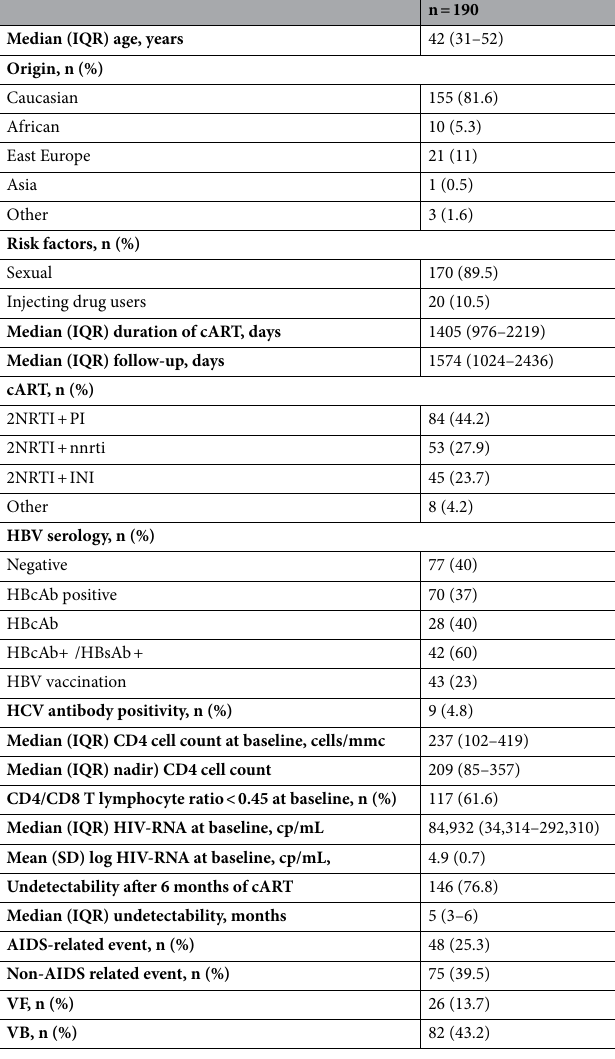
CD4+ and CD8+ T lymphocyte numbers and CD4/CD8 ratio in the 24 months after cART initia‑ tion in the two subgroups of HIV‑positive/HBcAb‑negative and HIV‑positive/HBcAb‑positive patients. Differences between HBcAb-positive and HBcAb-negative HIV patients are shown in Fig. 2A-C and in Table S1. Reduced CD4+ T lymphocyte absolute counts were found in the HBcAb-positive group before starting cART (baseline: 185 cells/mmc [88–373] vs. 271 cells/mmc [118.5–445.5], p = 0.02; in the HBcAb-posi- tive group vs. HBcAb-negative group, respectively) (Fig. 2A). With respect to CD4/CD8 ratio values (Fig. 2C), no difference was noted between the two patient groups up to 3 months after cART initiation. From 4 to 12 months, a significantly higher CD4/CD8 ratio was observed in HIV monoinfected subjects than in HBcAb+ HIV+ indi- viduals (month 4: 0.49 [0.3–0.7] vs. 0.37 [0.26–0.63], p value = 0.02; month 5: 0.51 [0.32–0.78] vs. 0.4 [0.32–0.66],